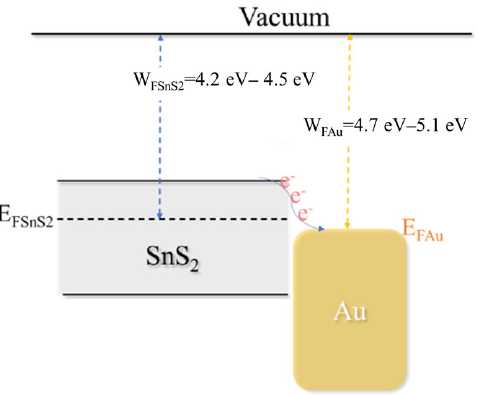
Figure 13. Schematic diagram of the charge transfer between the SnS 2 nanosheet and Au nanoparticles. This led to the larger change in the resistance of the Au/SnS 2 -based